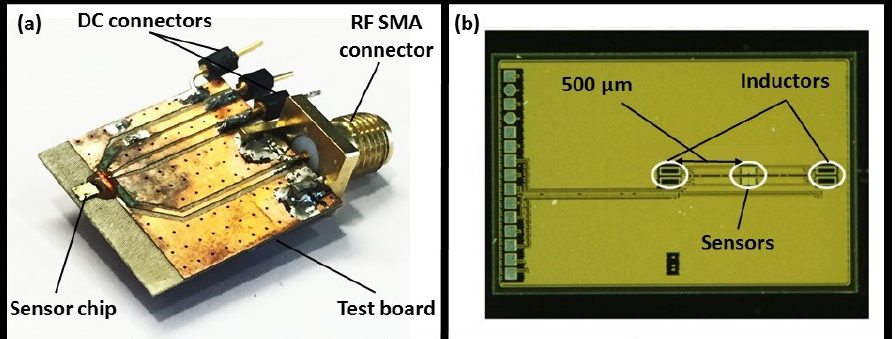
Figure 1. ( a ) First generation of the dielectric sensor, ( b ) sensor chip showing IDCs and inductors embedded in a CMOS oscillator [27,28].